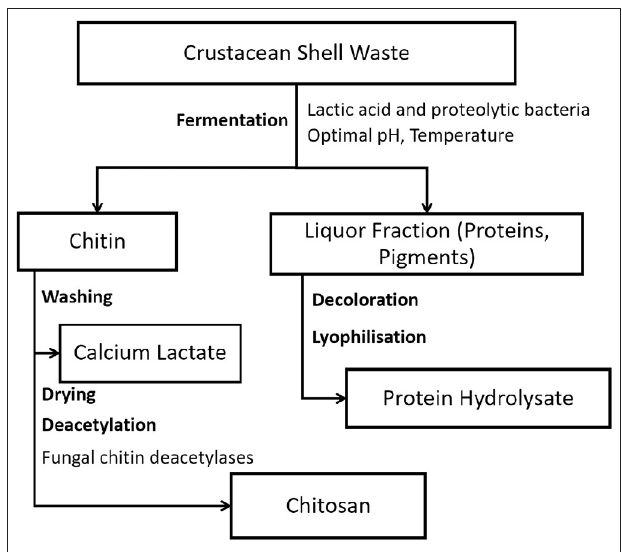
FIGURE 3 | Bioconversion processes for extraction of chitin, chitosan, and protein hydroluzate (adapted from Vázquez et al., 2013).